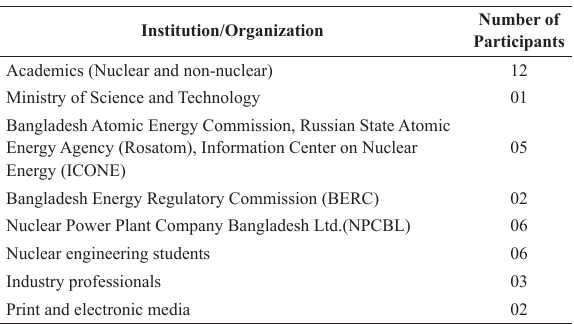
Table 1. Participants’ organization and respective numbers